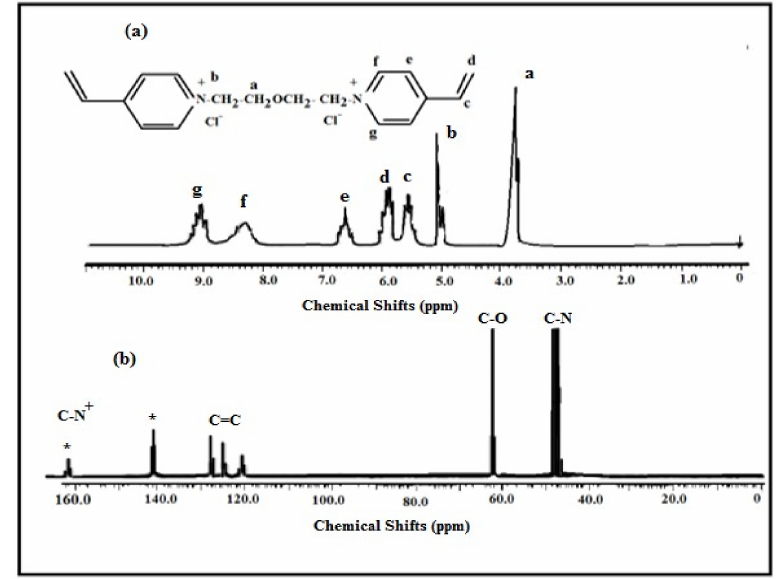
Figure 1. The ( a ) 1 H-NMR and ( b ) 13 C-NMR spectra of